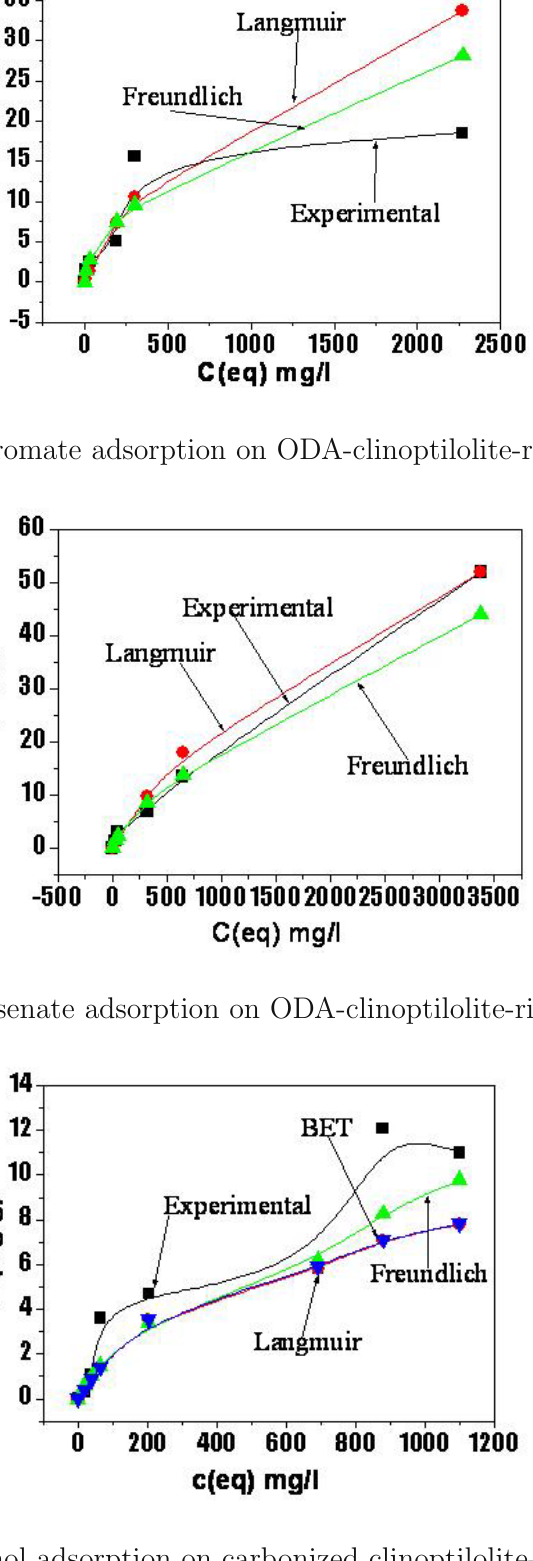
Fig. 3 Phenol adsorption on carbonized clinoptilolite-rich